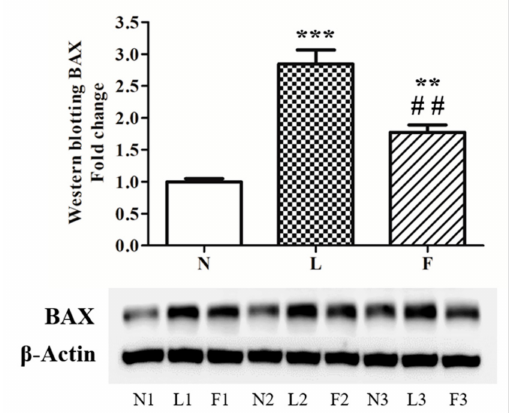
Figure 5. BCL2-associated X (BAX) protein levels. The analyses of BAX protein levels were monitored by western blotting. The figure shows a representative western blot and the densitometric analyses were graphically represented as mean ± standard error on the mean (SEM) of six di ff erent animals for each group expressed as fold change vs. N. Significant di ff erences are shown: ** p < 0.01 vs. N; *** p < 0.001 vs. N; ## p < 0.01 vs L.